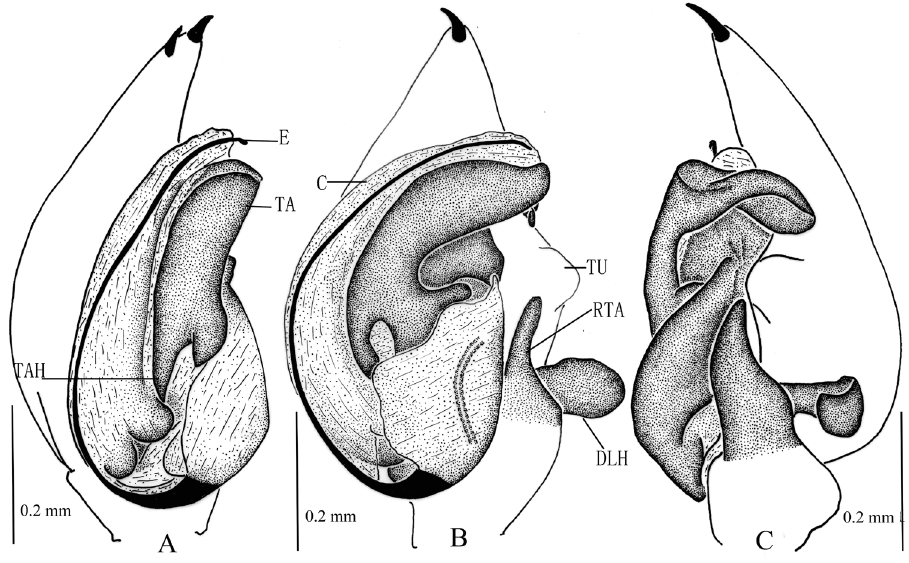
Figure 5. Zodarion planum sp. n. A–C Left male palp of male holotype ( A prolateral view B ventral view C retrolateral view). Abbreviations: C, conductor; DLH, dorsolateral hook; E, embolus; RTA, retrolateral tibial apophysis; TA, tegular apophysis; TAH, tegular apophysis hook; TU,